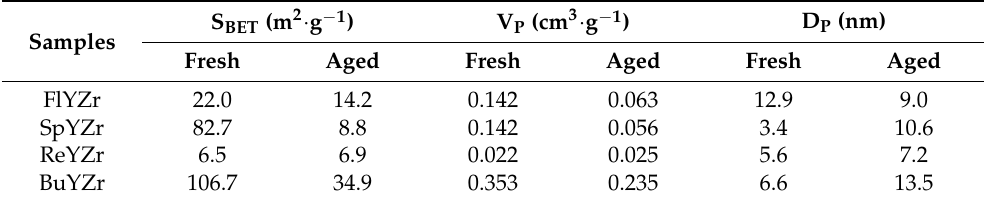
Table 1. Specific surface area and pore structure parameters of Y-ZrO 2 composite oxides with dif- ferent morphologies. Figure 3. Adsorption-desorption isotherms of fresh ( a ) and aged ( b )Y-ZrO 2 compositbe oxides with different morphologies.